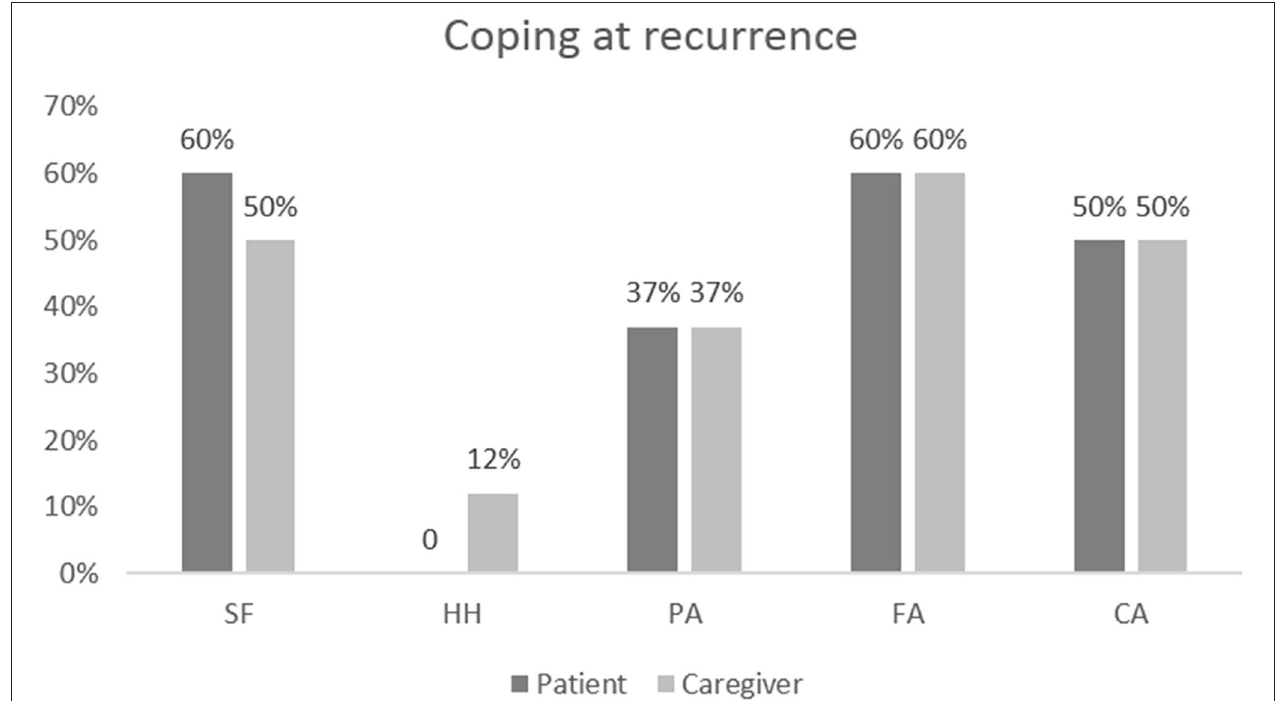
FIGURE 1 | Results of coping assessments at baseline in patients and caregivers at the individual level.